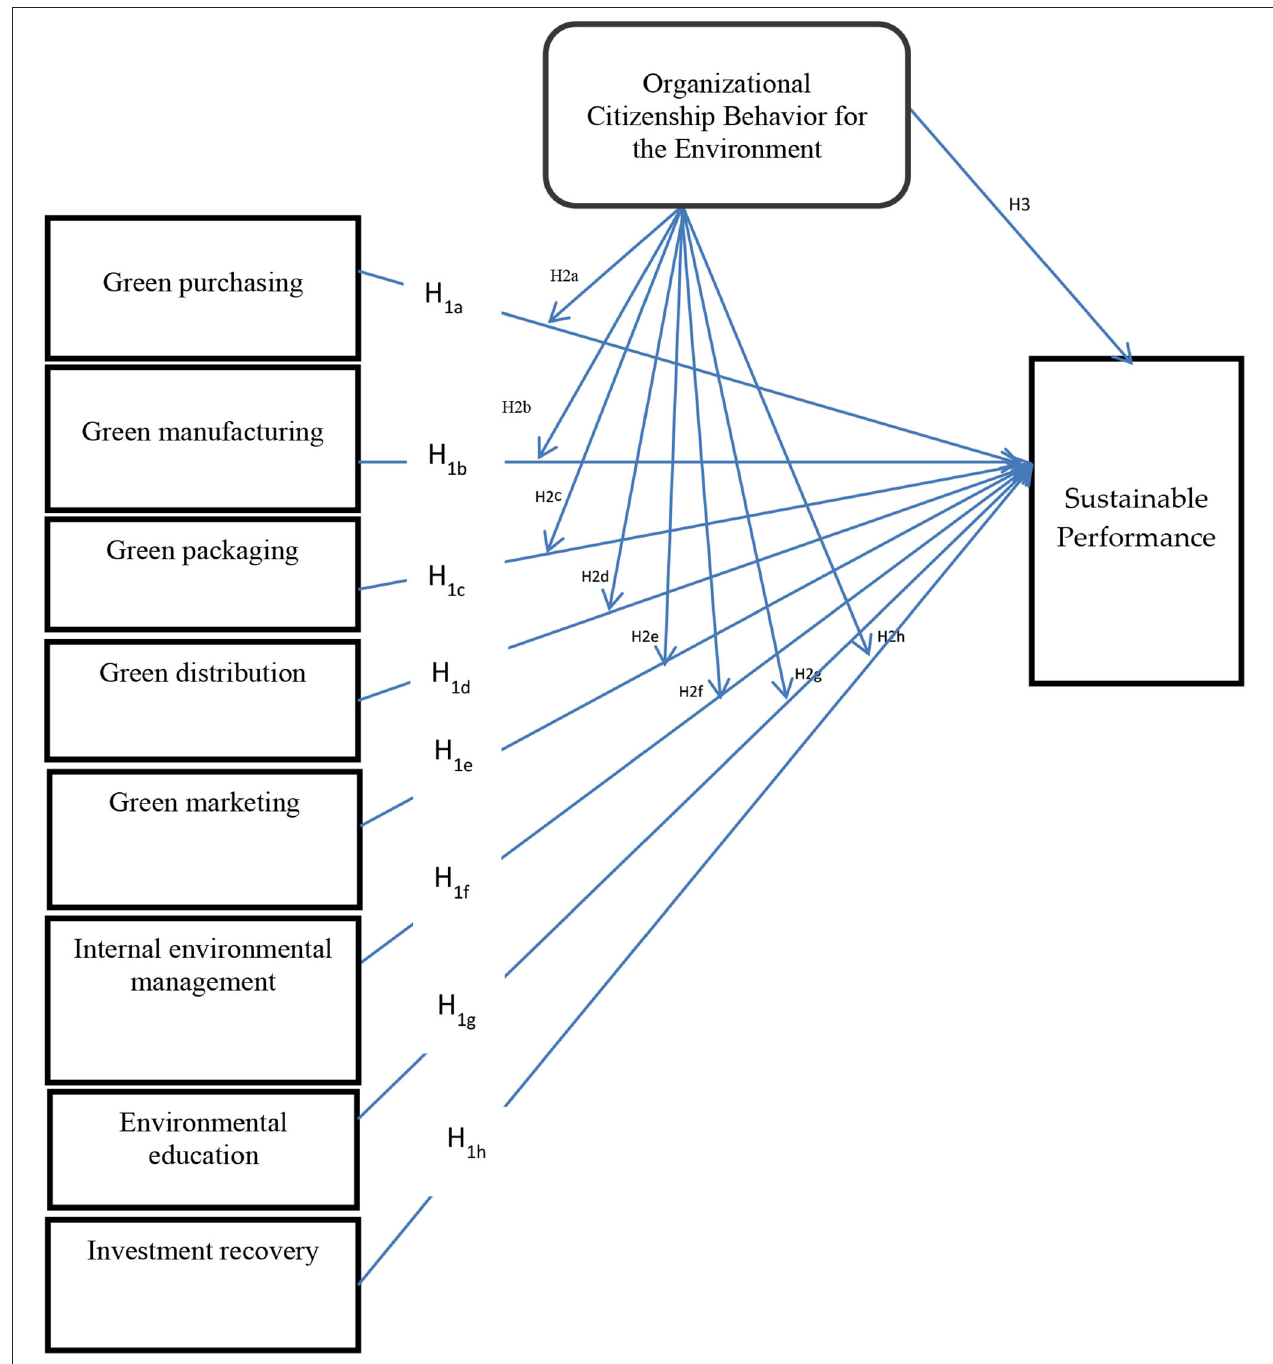
FIGURE 1 | Conceptual model and